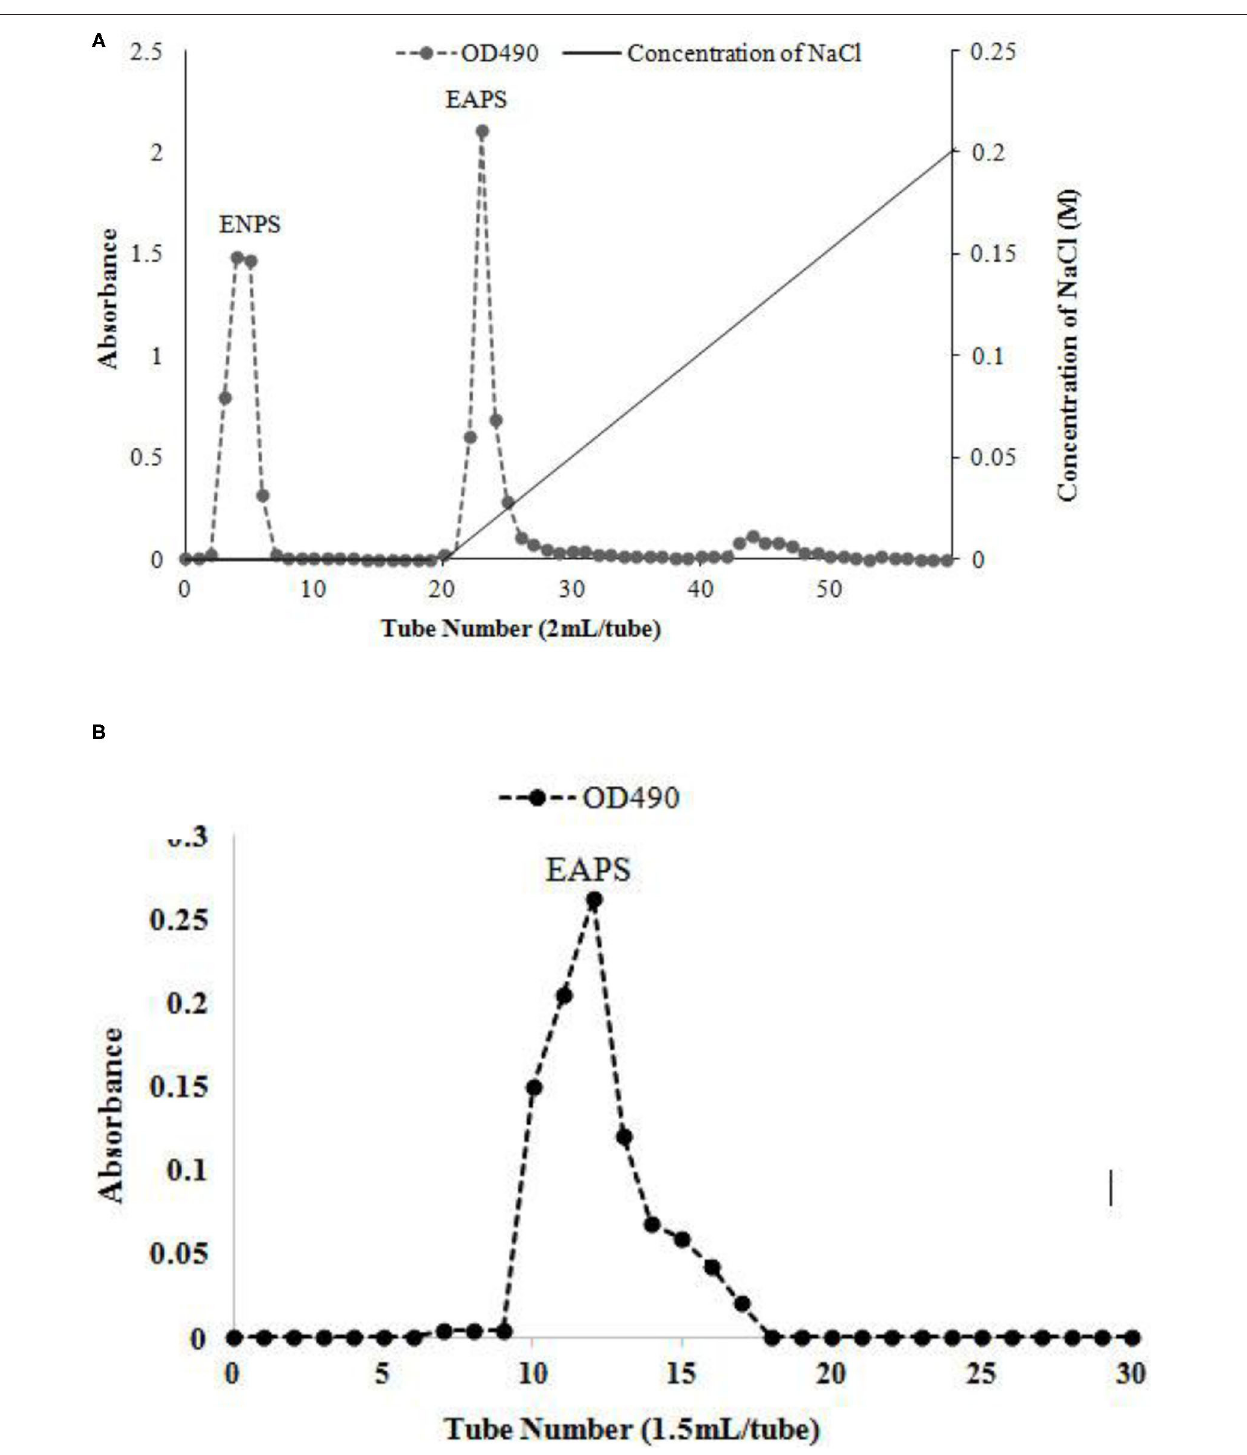
FIGURE 1 | Elution curve of the water-extractable polysaccharide on the diethylaminoethyl (DEAE)-cellulose 52 anion exchange chromatography (A) and size exclusion chromatography (B) . fraction and one acidic polysaccharide fraction were obtained, the EPS in each concentration was shown in Figure 1A . Fractions 3–8 were defined as ENPS, fractions 22-30 as EAPS. We purified